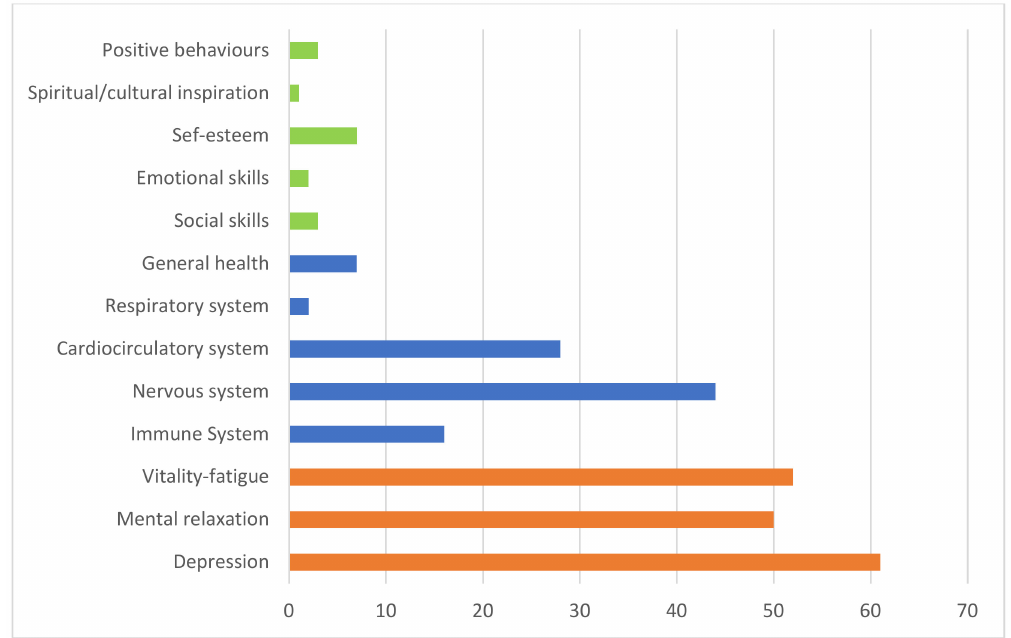
Figure 3. Number of papers in which the specific e ff ects of forest-based initiatives are assessed as statistically significant * , divided by subcategories of e ff ects (i.e., green for social, blue for physiological and orange for psychological e ff ects) * level of significance is established by each single